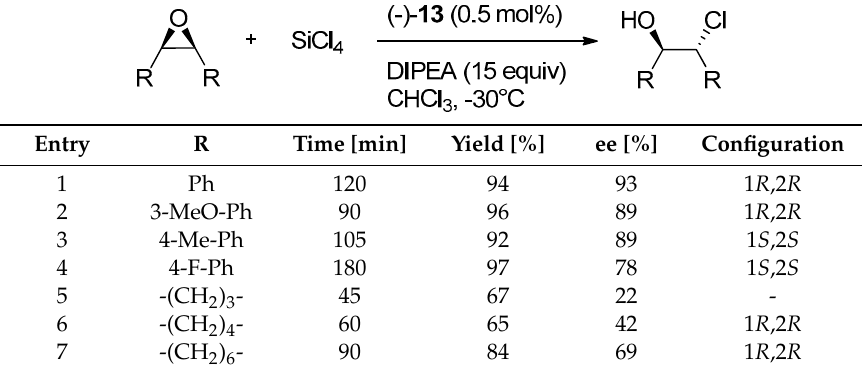
Table 3. Desymmetrization of meso-epoxides with SiCl 4 catalyzed by 13 [18].